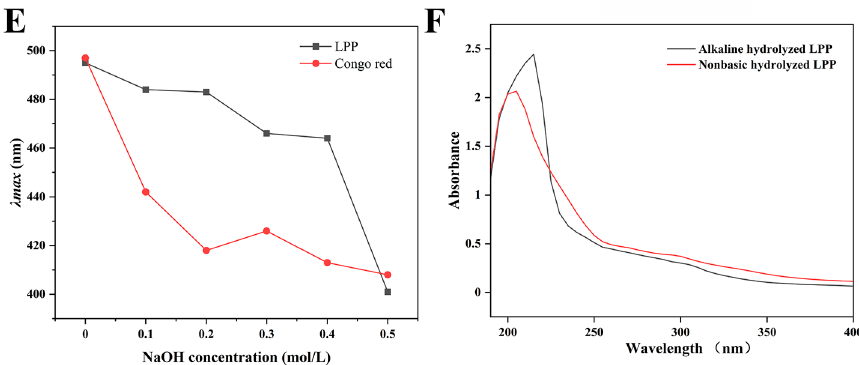
Figure 1. ( A ) Monosaccharide composition, ( B ) XRD, ( C ) UV-vis spectrum, ( D ) FT-IR spectroscopy, ( E ) Congo red experiment, and ( F ) β -elimination reaction for the Lonicera caerulea L. pomace polysaccharide LPP.